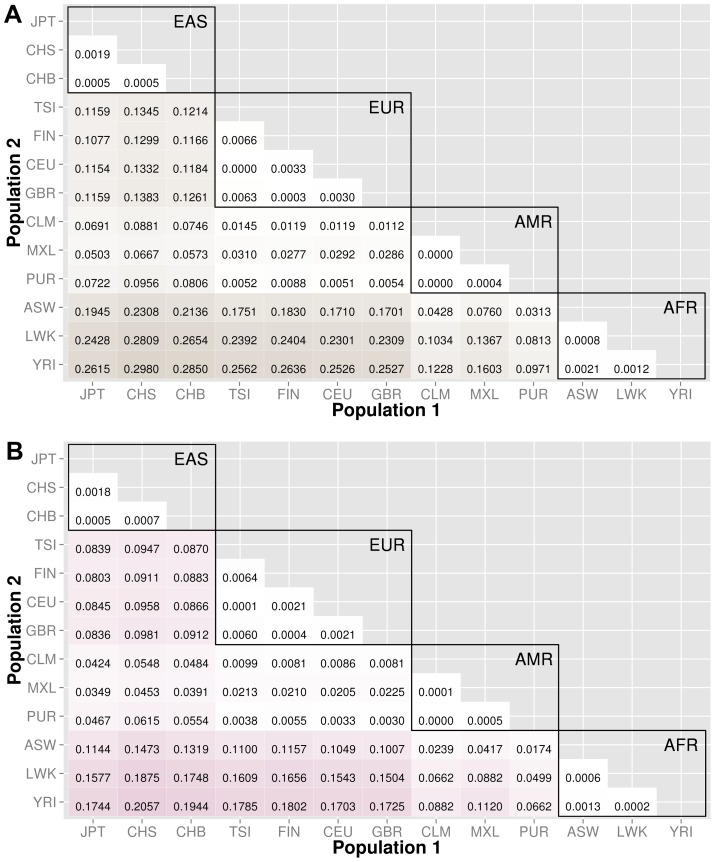
Proportion of significantly different bins for gene-exon filters: A) nonsynonymous and B) predicted deleterious variants.The abbreviations for the each population on are on the x and y-axes. The numbers in each block and the color intensity [0,1] indicate the proportion of significant bins (after Bonferroni correction) for the 1000 Genomes populations on each axis, where the darker the color, the higher the proportion of significant bins. In general, the x-axis is organized with African descent populations on the far right and increasing differentiation with regard to low frequency burden towards the left (i.e. populations of Asian descent have the highest proportion of significant bins compared to African descent groups). Filtering gene exon regions by mutation type and predicted functional significance lead to smaller bins and overall greatly reduced proportions of significance.